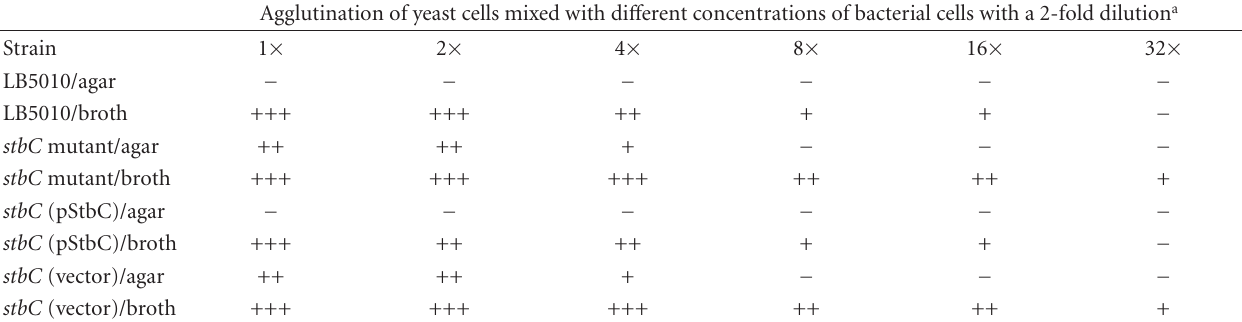
Table 2: Yeast agglutination test of Salmonella enterica subsp. enterica serovar Typhimurium LB5010 and stbC mutant